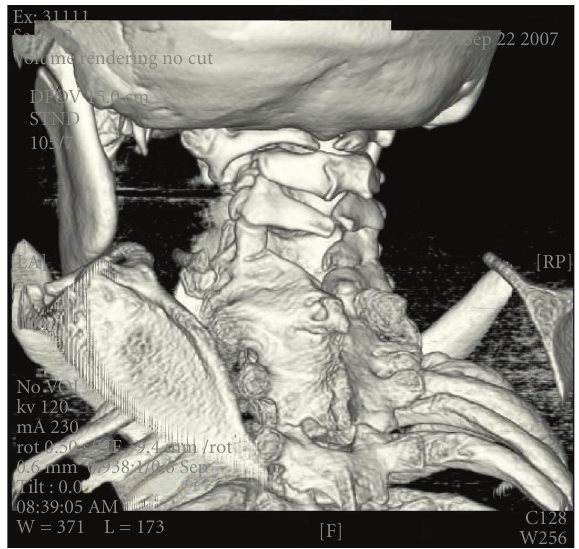
Figure 1: Computed Tomography of the C Spine, with 3D recon- struction, showing Klippel-Feil anomaly comprising of the fusion of multiple cervical and upper thoracic